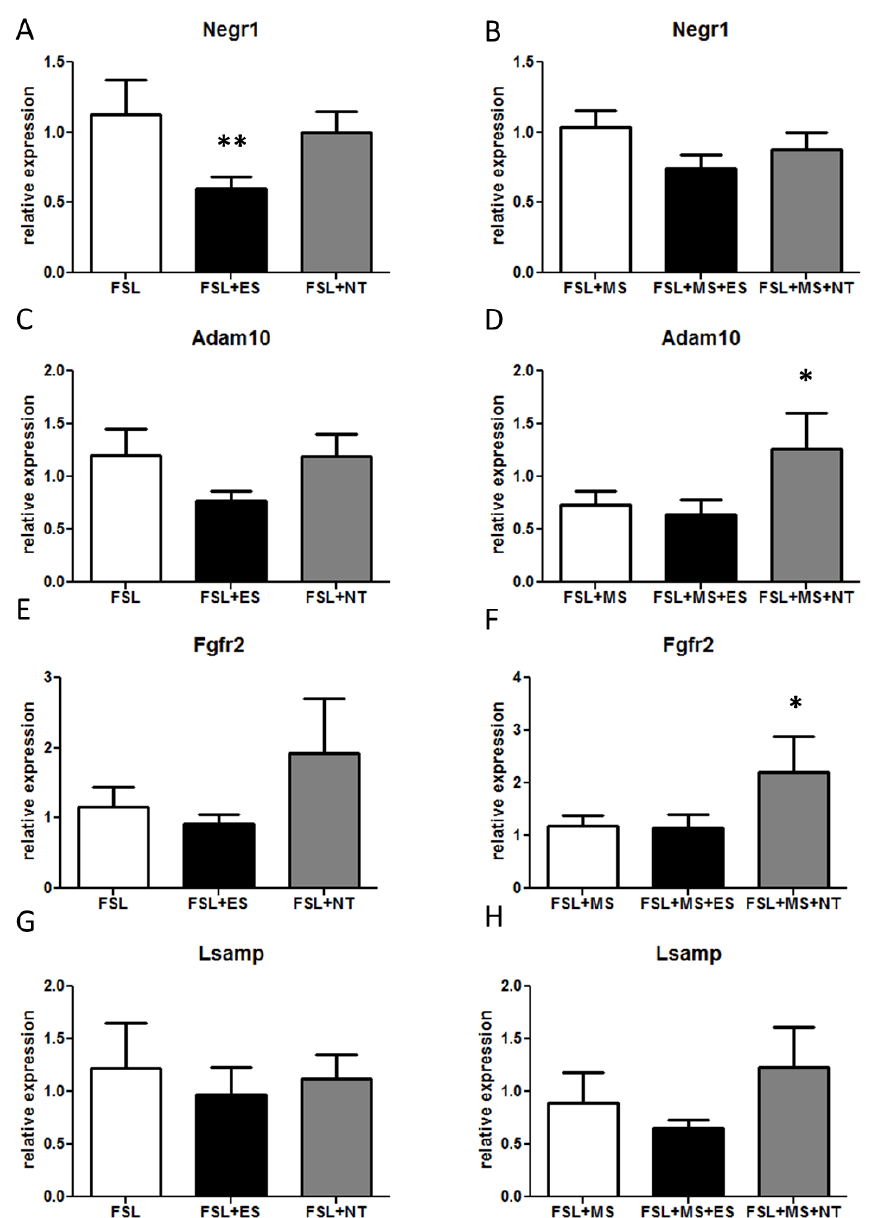
Figure 1. mRNA levels of genes belonging to the Negr1-Fgfr2 pathway in the hypothalamus after ES NT or vehicle administration. FSL rats were either left undisturbed in their home cage (n-MS, A , C , E , G ) or exposed to MS ( B , D , F , H ) as described in the Methods section. ( A , B ) Negr1 expression; ( C , D ) Adam10 expression; ( E , F ) Fgfr2 expression; and ( G , H ) Lsamp expression. * p < 0.05, ** p < 0.01 in the planned comparison vs. vehicle; n = 6/group.